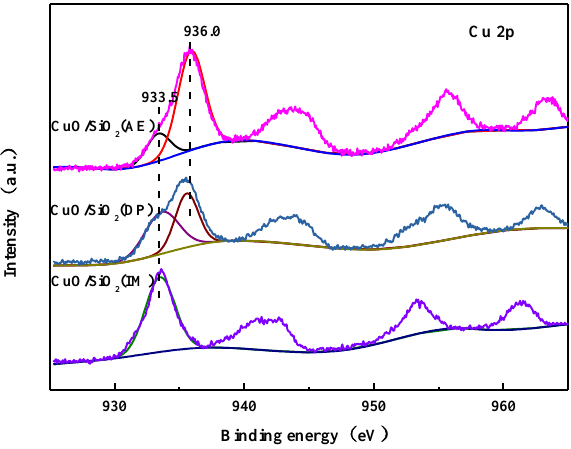
Figure 7. X-ray photoelectron spectra (XPS) of CuO / SiO 2 catalysts.